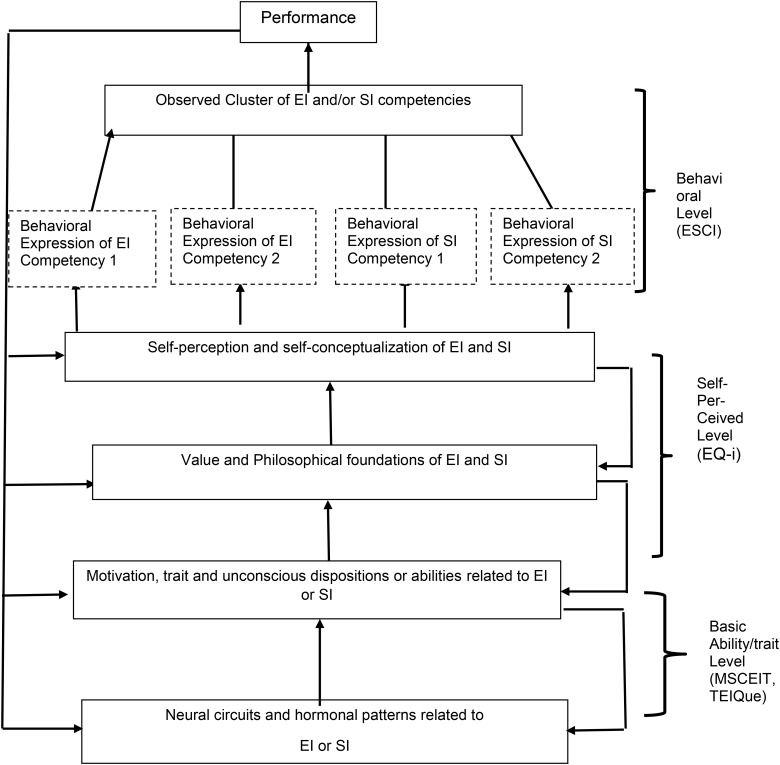
Emotional intelligence (EI) as a multi-level theory [from Cherniss and Boyatzis (2013) which was adapted from Boyatzis (1982, 2009)].